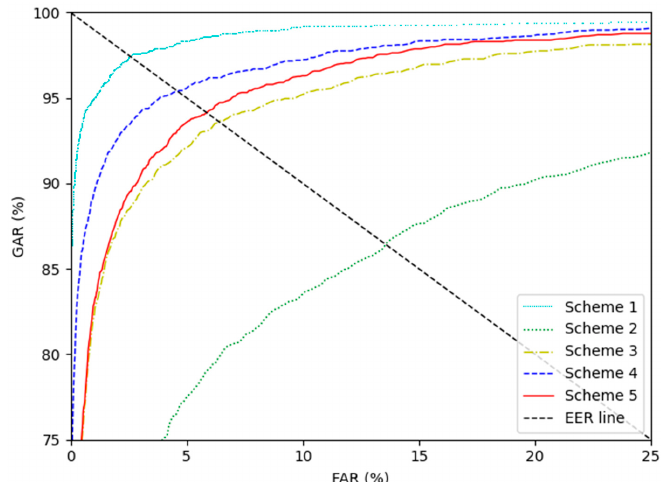
Figure 15. ROC curves of finger-vein recognition for schemes 1–5 with SDU-DB (random motion blur and optical blur with intensity 11 × 11 (Gaussian filter size) and 11 (Gaussian filter standard deviation)).